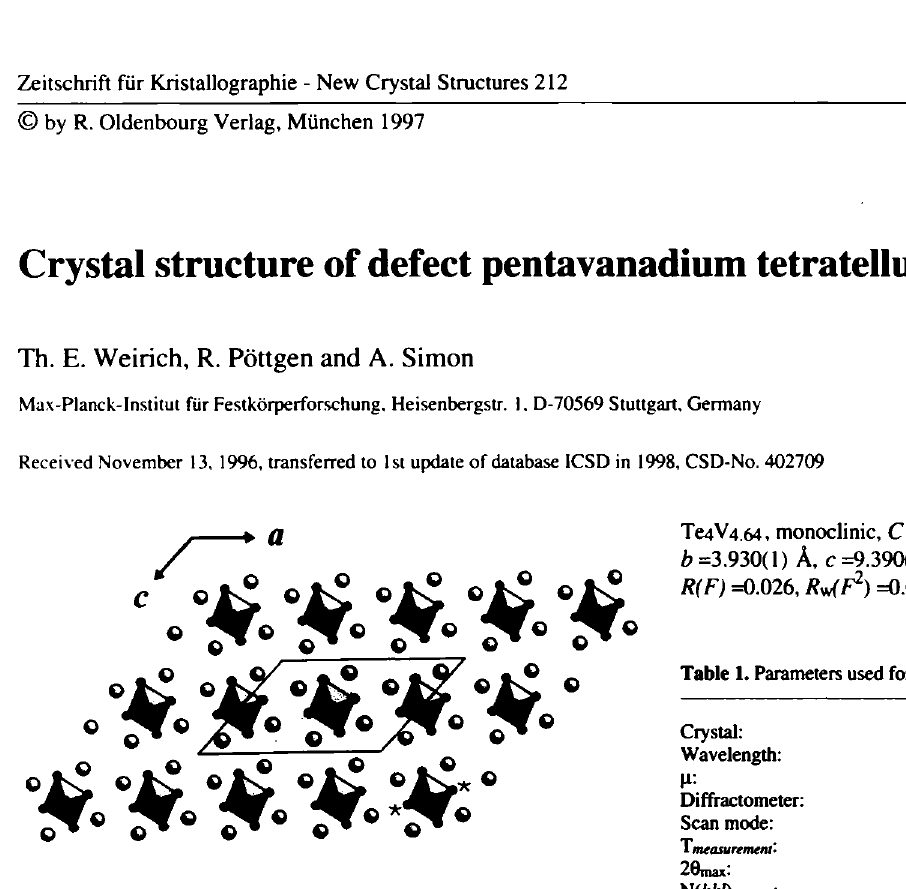
Fig. 1. Projection along the short b axis with emphasis on the condensed Ve octahedra (V(2) = *).